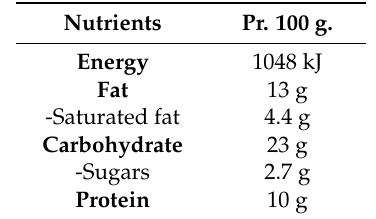
Table 2. Composition of the ad libitum